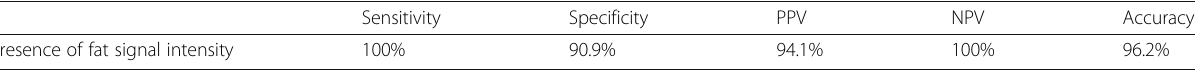
Table 1 Showed sensitivity, specificity, PPV, NPV, and accuracy of presence of fat signal intensity in differentiating fat necrosis from recurrent breast